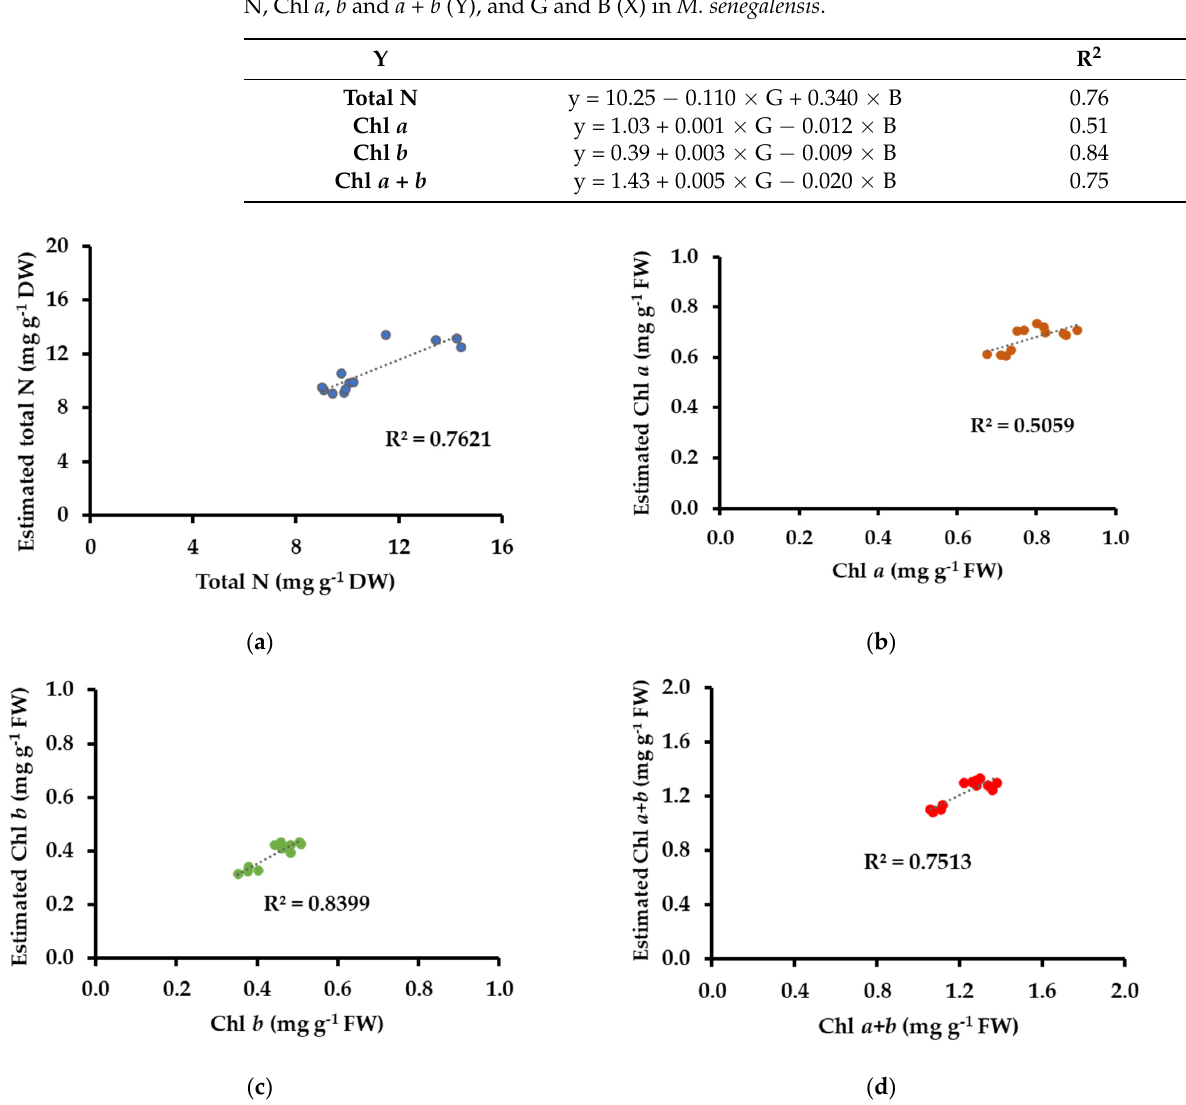
Figure 3. Visualization of the different correlations studied in M. senegalensis. ( a ) Total N (mg g − 1 DW), ( b ) Chl a (mg g − 1 FW), ( c ) Chl b (mg g − 1 FW), ( d ) Chl a+b (mg g − 1 FW).